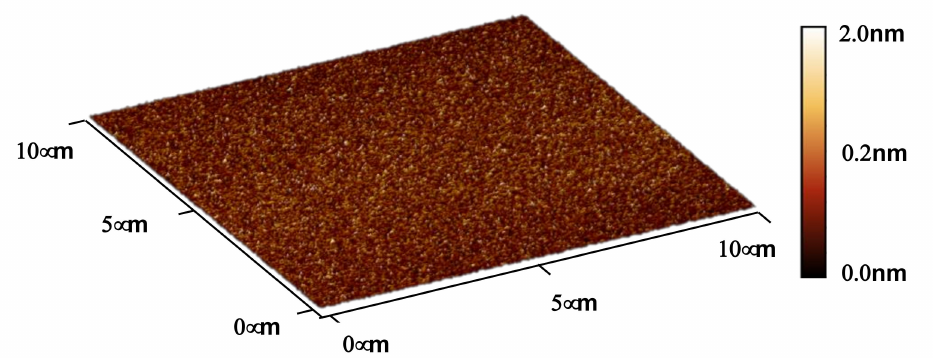
Figure 11. Atomic force microscopy (AFM) micrograph of as-deposited SiC films grown from TSCH at a 650 ◦ C substrate